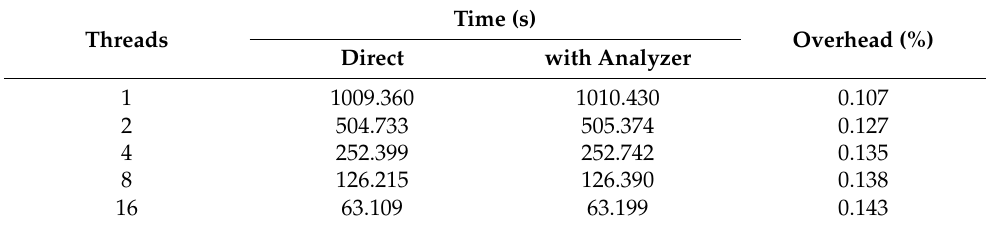
Table 2. Instrumentation overhead while varying the number of threads with the number of samples fixed to one